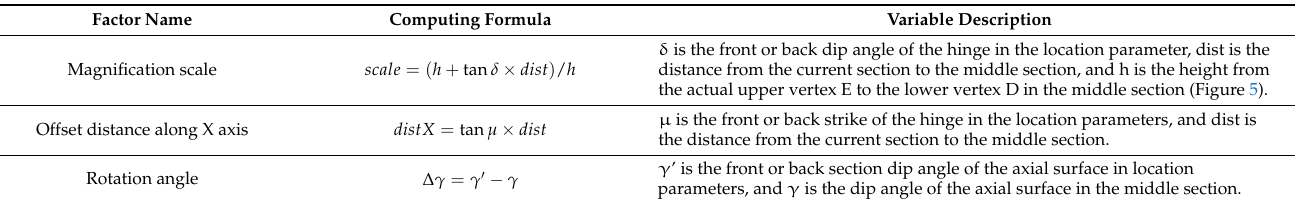
Table 3. Affine transformation